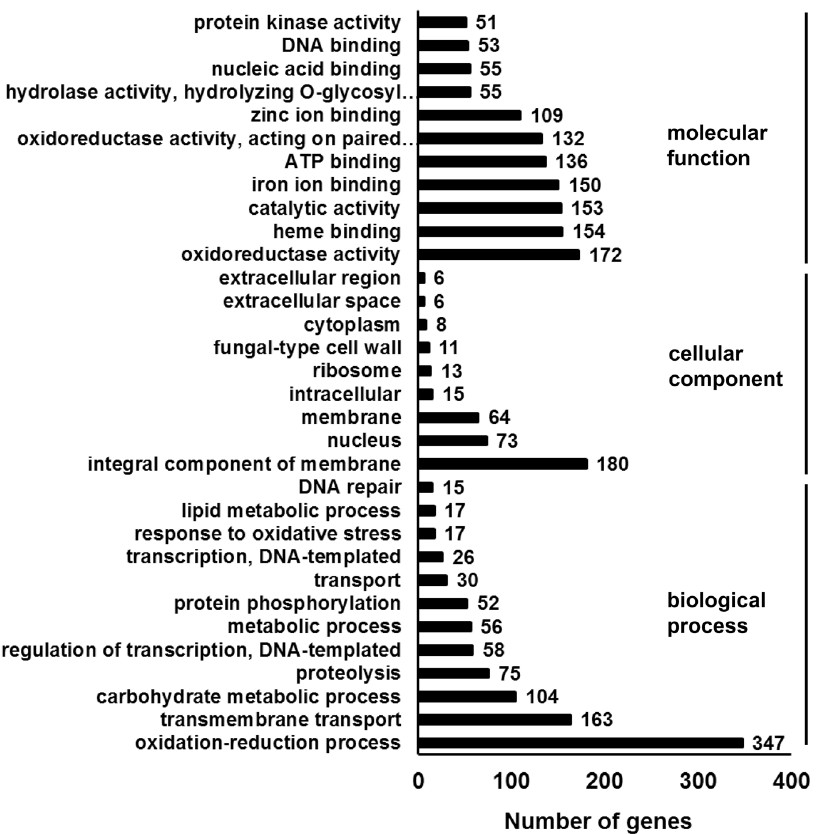
Figure 8. Gene Ontology analysis. The fungal mycelium was incubated with cAMP and IBMX. Transcriptome sequencing was performed to identify differentially expressed genes between the control and cAMP-treated mycelium. The differentially expressed genes were further mapped to the gene ontology (GO) database. Three main categories (biological process, cellular component, and molecular function) are